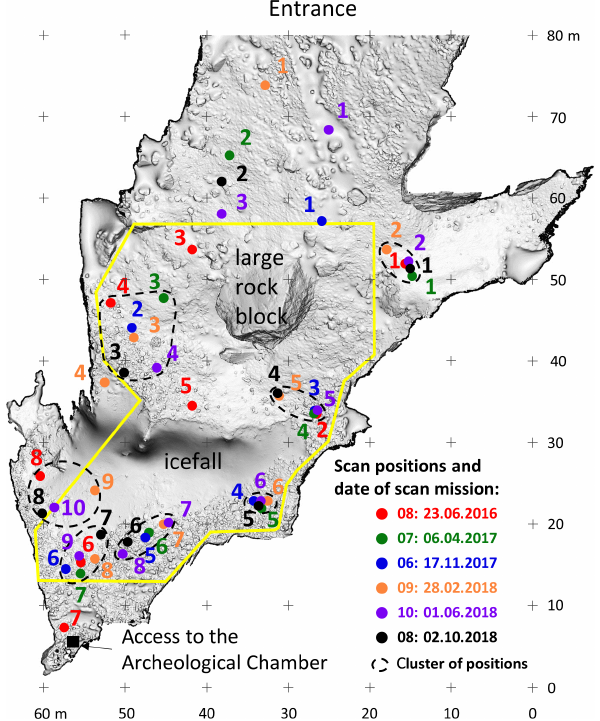
Figure 6. Distribution of scan positions of individual scan missions presented in the plan of the cave derived from TLS mapping. The yellow polygon shows a defined area of interest (AoI) for computa- tion of changes in ice